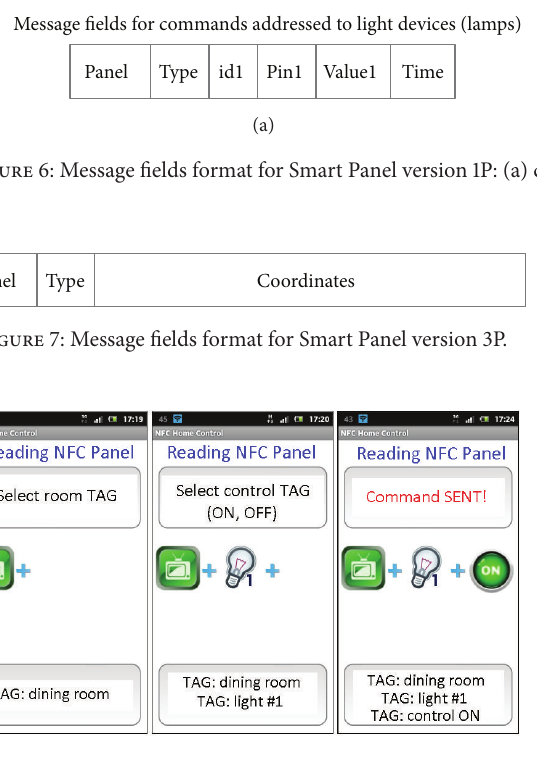
Figure 8: Sequence of visual notifications provided by the applica- tion to signal the correct composition of a command for the case of Smart Panel version 3P.